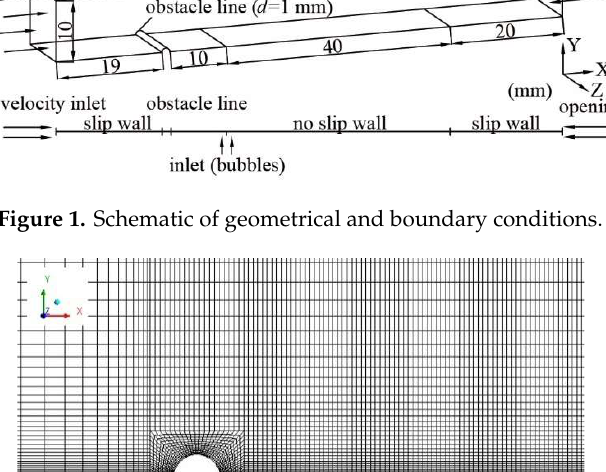
Table 1. Flow field and bubble properties.